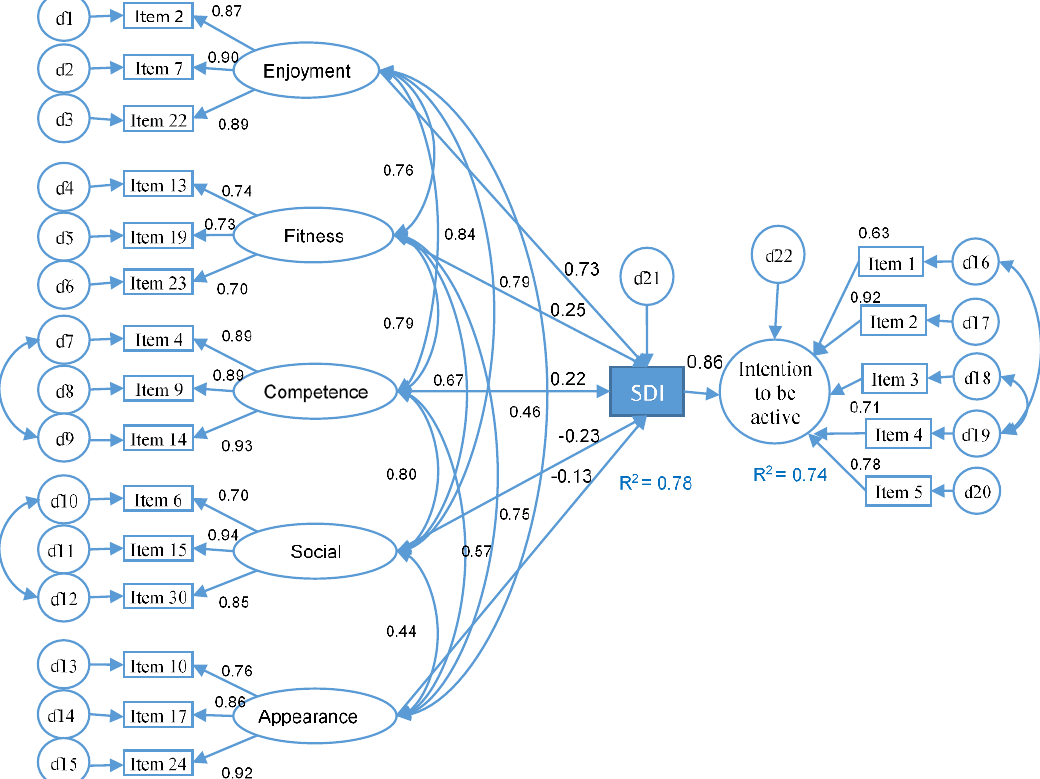
Figure 1. Structural equation model 1 in university students.